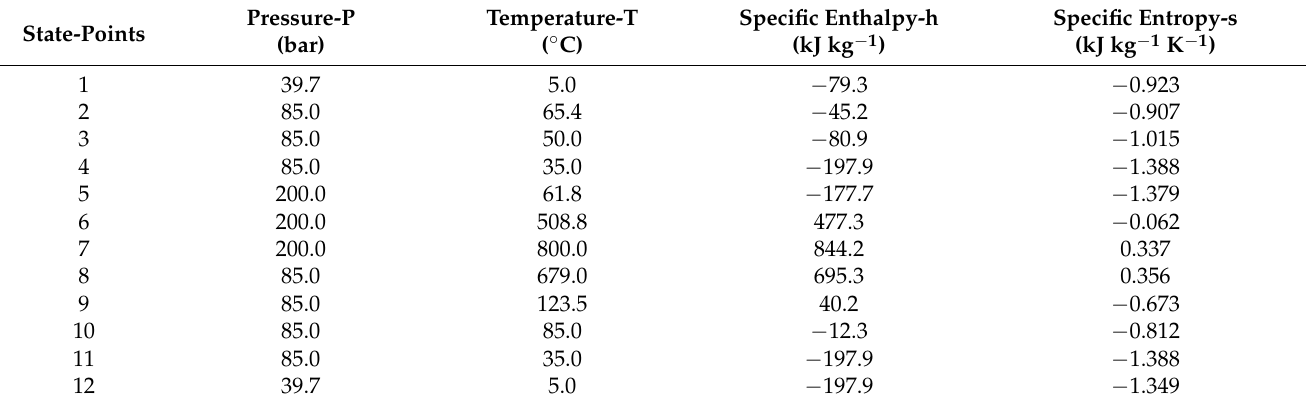
Figure 3. Temperature-specific entropy (T-s) diagram for the studied polygeneration system in nominal operating conditions (logarithmic vertical axis). Table 2. Thermodynamic state-points in nominal operating